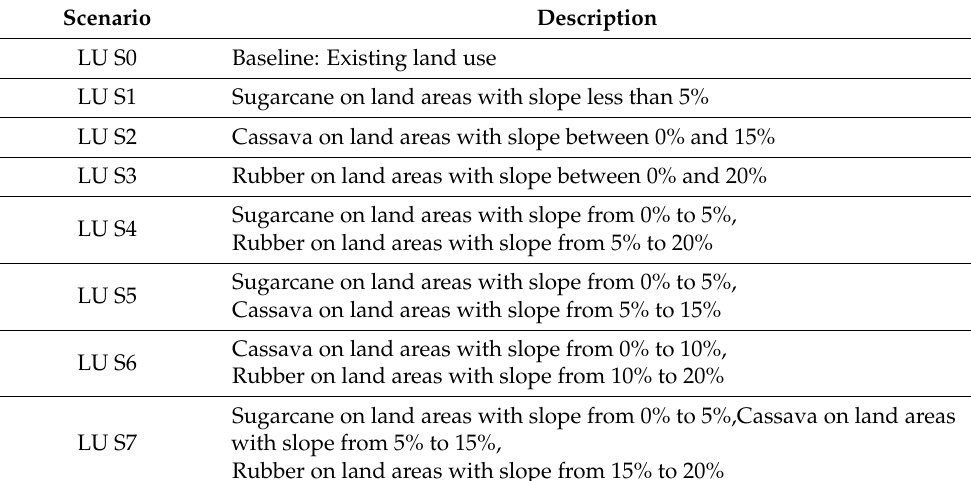
Table 3. The Huai Ta Poe watershed degradation scenarios.